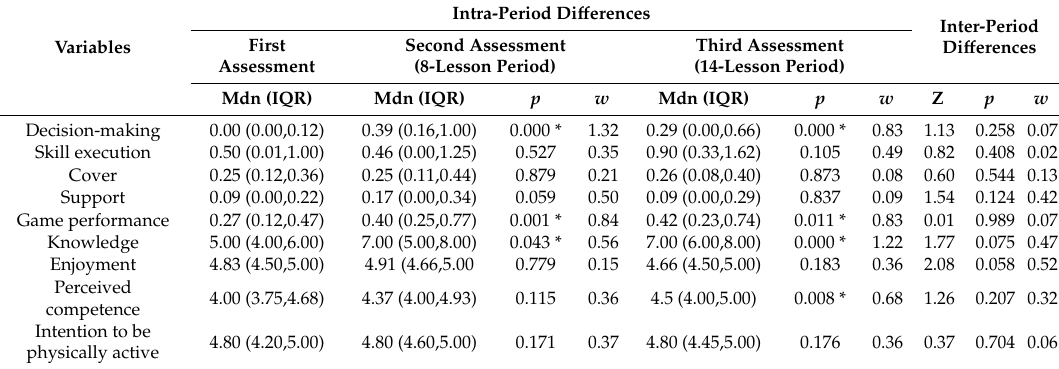
Table 3. Medians, Interquartile Ranges and Significant Di ff erences of the Variables at the 8- and 14-Lesson